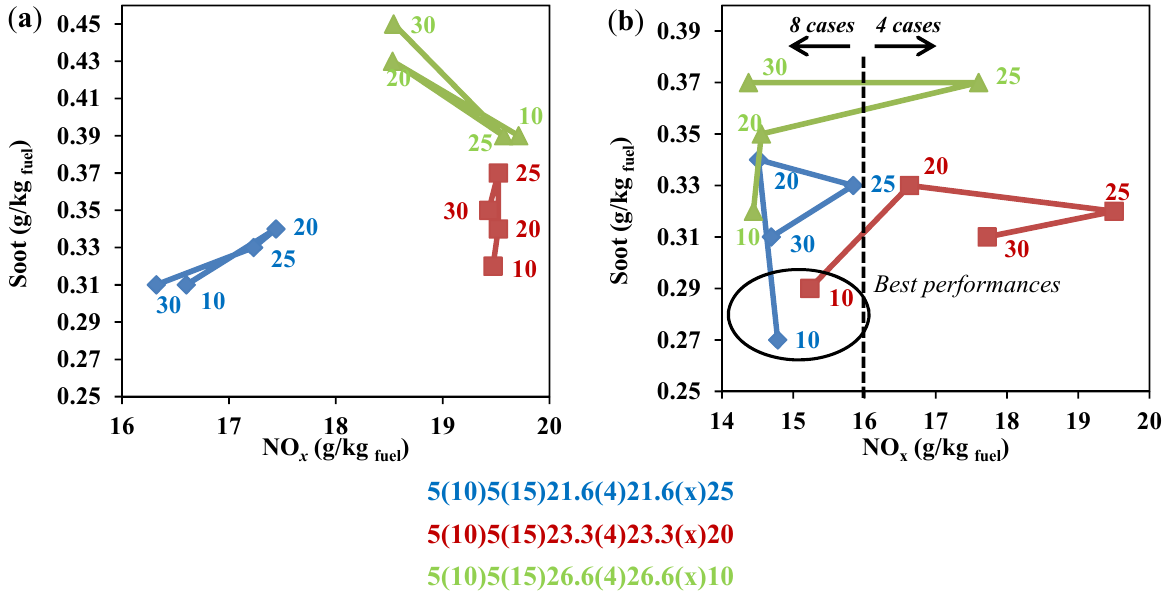
trade-off for ( a ) 10% and ( b ) 20% EGR. Figure 13. Soot-NO x